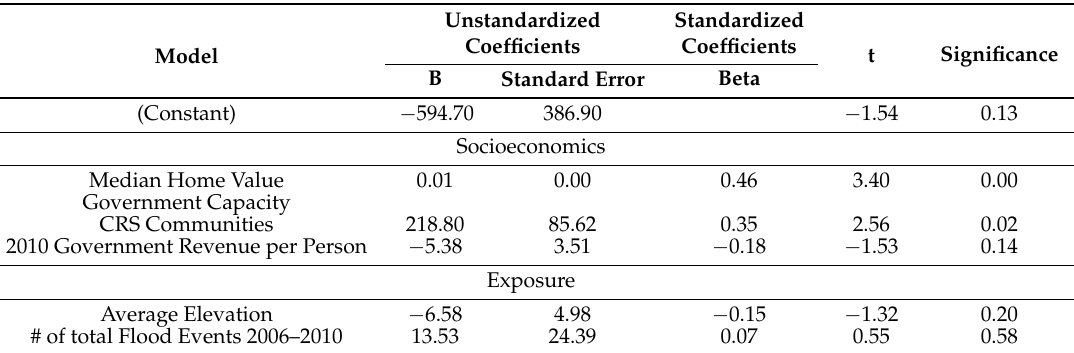
Table 7. Multiple regression analysis